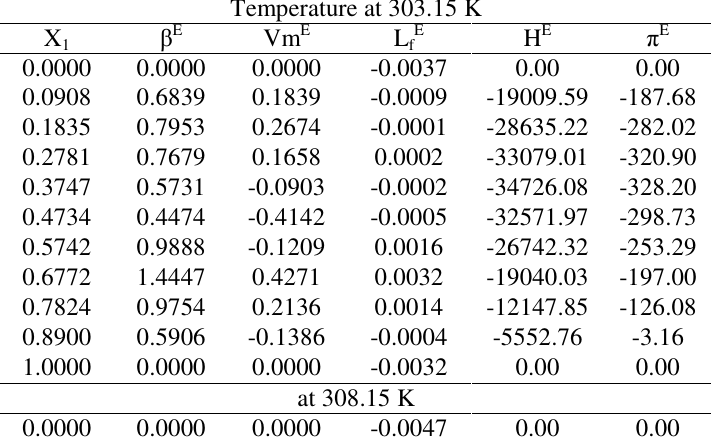
Table 2. Excess values of adiabatic compressibility ( β E ), molar volume (Vm E ), intermolecular free length (L fE ), enthalpy (H E ) and internal pressure ( π E ) for cylohexane with o